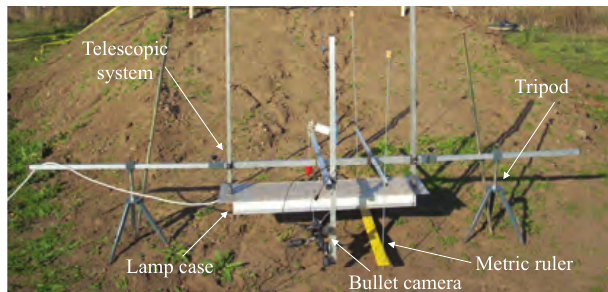
Fig. 2. Experimental apparatus including the light source and the video acquisition units. The metric ruler is used for calibrating ac- quired videos.